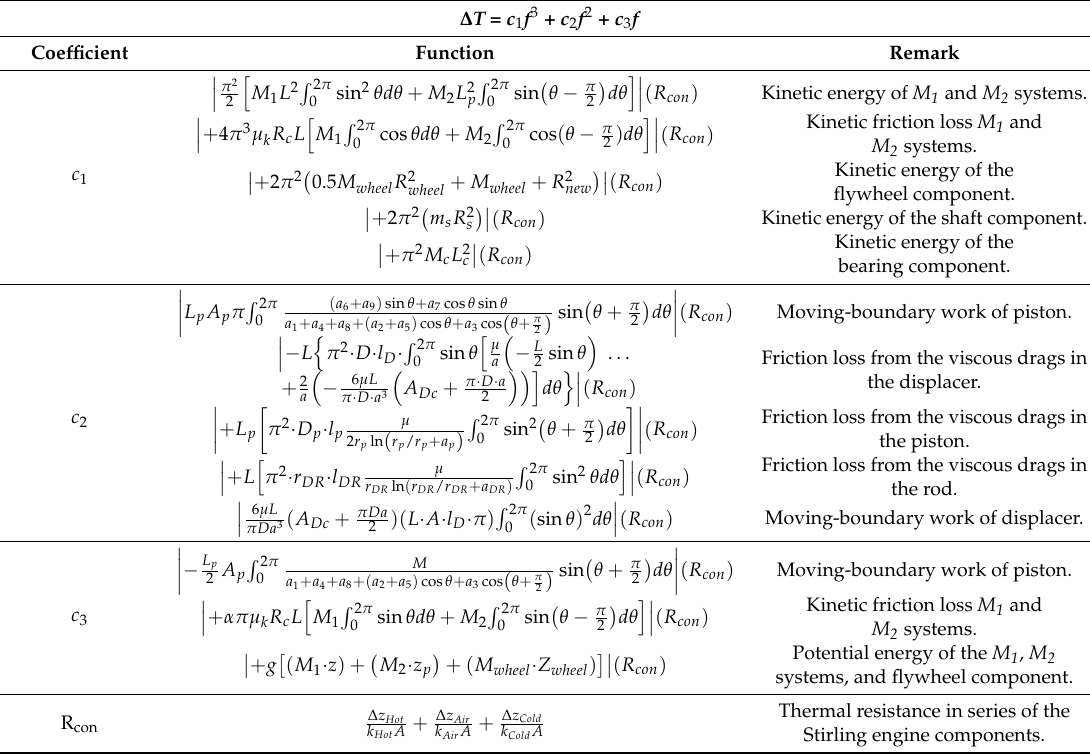
Table A1. The coefficient of Equation